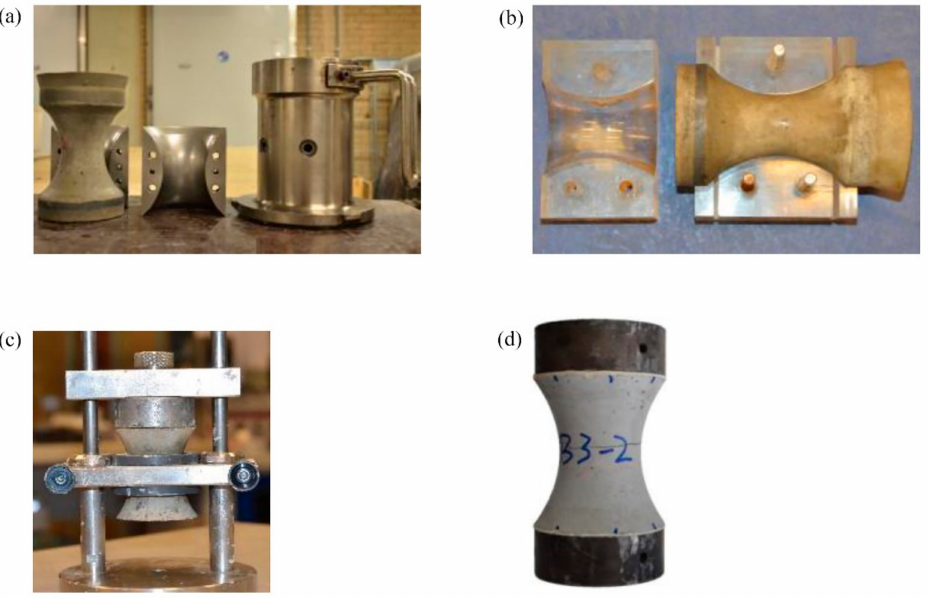
Figure 2. Preparation procedures of the parabolic-shape concrete specimen. ( a ) the parabolic specimen casted through a splitting mould inside the gyratory mould; ( b ) the Perspex cutting mould; ( c ) the gluing assistive device; ( d ) the specimen with steel